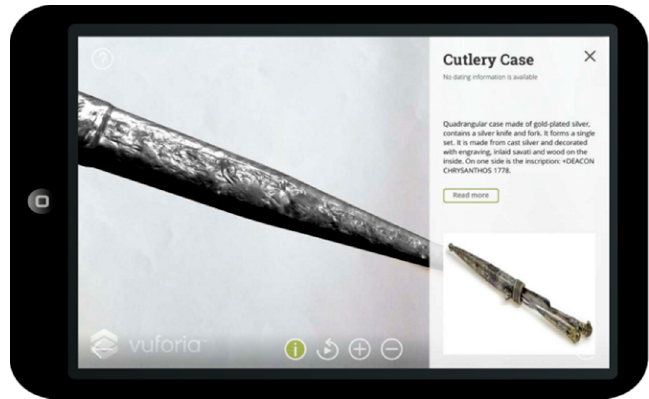
Figure 6. Screenshot of a high-poly rotated 3D model projected on demand—when available—to allow users to examine details on the surface of the artefact.